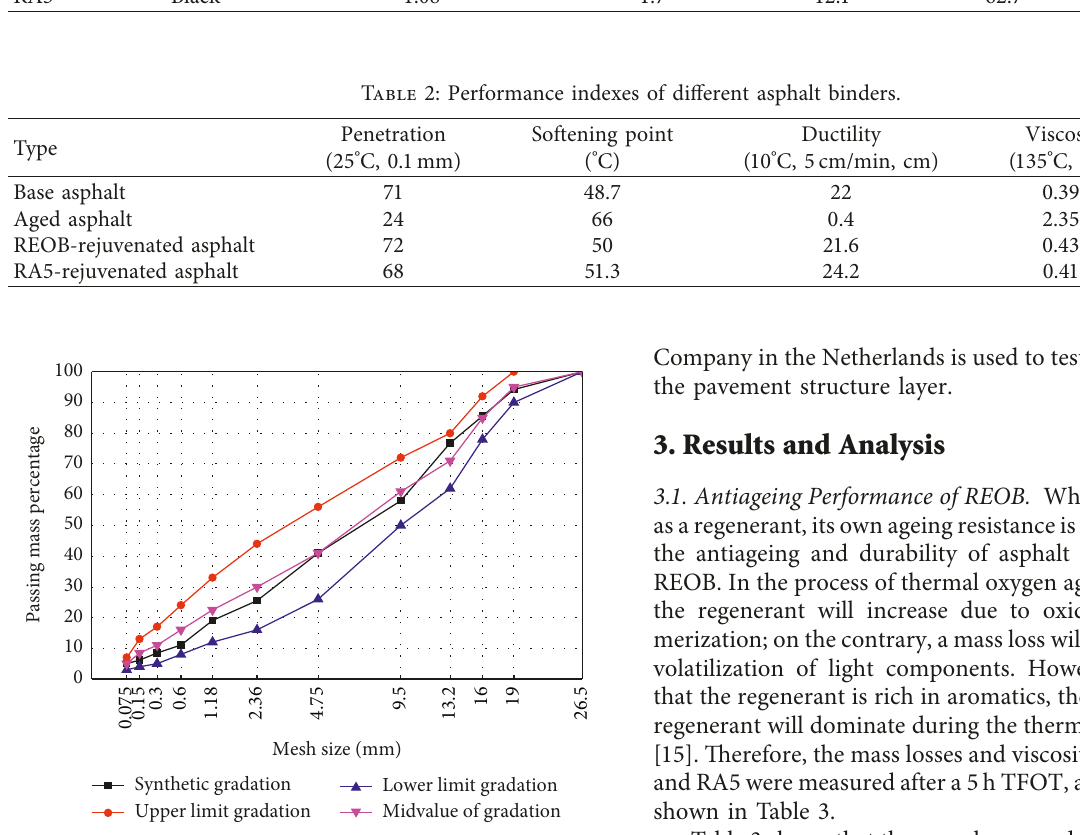
Figure 1: AC-20 aggregate gradation